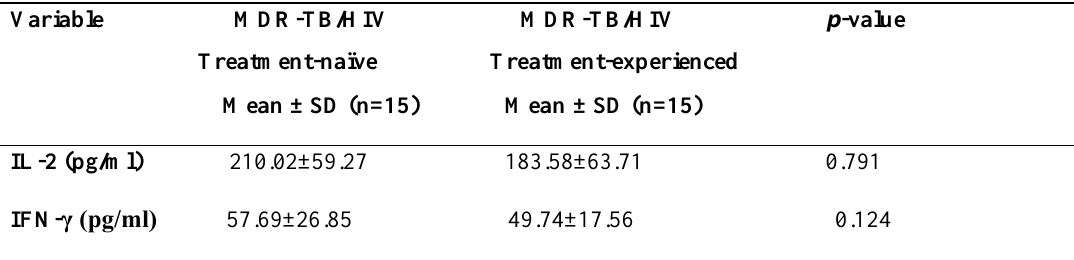
Table 4. Effect of antiretroviral therapy and anti-TB therapy on IL-2 and IFN-γ.